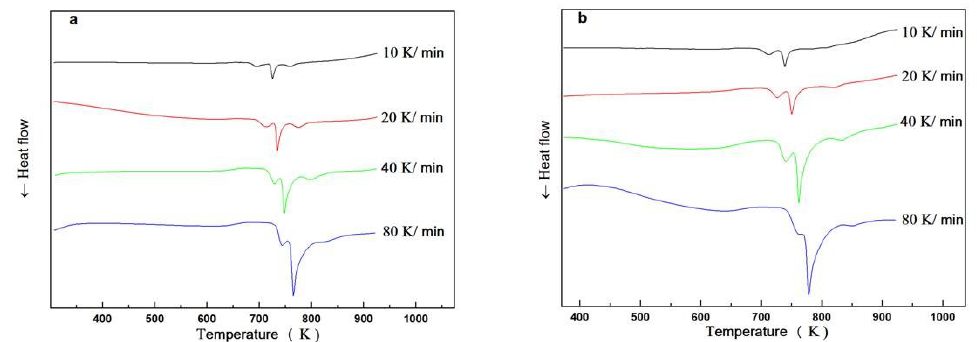
Figure 3. Differential scanning calorimetry (DSC) curves of two materials at different heating rates: ( a ) the metallic glass Zr 41.2 Ti 13.8 Cu 12.5 Ni 10 Be 22.5 ; ( b ) the W particles/Zr 41.2 Ti 13.8 Cu 12.5 Ni 10 Be 22.5 metallic glass matrix composite. Table 1. T g , T x , ∆ T , and T p of the metallic glass Zr 41.2 Ti 13.8 Cu 12.5 Ni 10 Be 22.5 and the